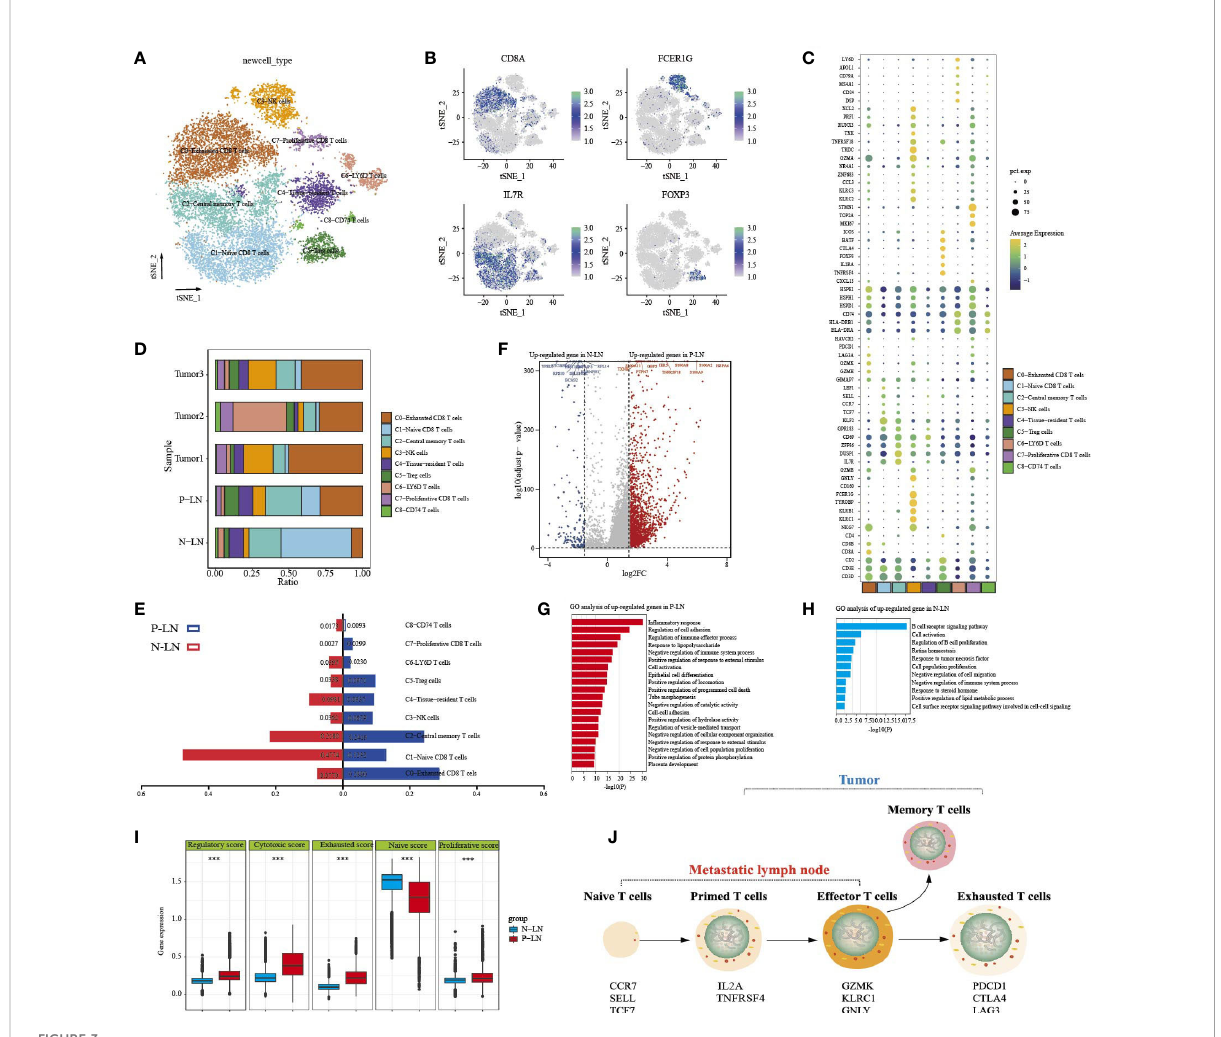
FIGURE 3 Analysis of NK/T- cell transition status in primary tumors and metastatic lymph nodes. tSNE of nine T/NK cell clusters, with each cell color-coded for nine cell types (A) . tSNE of marker genes for each cell type (B) . Dot plot of signi fi cant representative genes in nine cell types (C) . The proportion of each T/NK subpopulation in fi ve samples (D) . The difference of each subpopulation proportion between P-LN and N-LN (E) . Volcano plot showing differentially expressed genes of NK/T cells between P-LN and N-LN (F) . GO analysis of upregulated DEGs of all NK/T cells in P-LN (G) . GO analysis of upregulated DEGs of all NK/T cells in N-LN (H) . Comparison of a regulatory, cytotoxic, exhausted, naive, and proliferative score of all NK/T cells between P-LN and N-LN (***P < 0.001) (I) . Development characteristics of NK/T cells in metastatic LN and primary tumor (J)